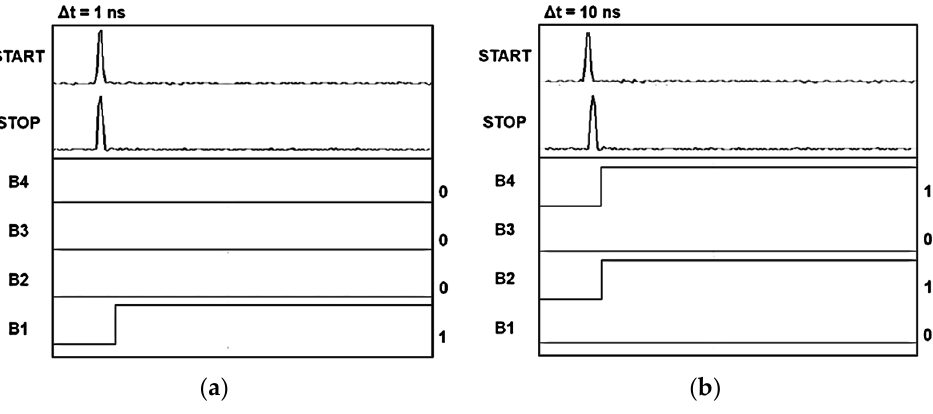
Figure 9. Measured TDC outputs of the LiDAR AFE IC at ( a ) 1 ns and ( b ) 10 ns time intervals.